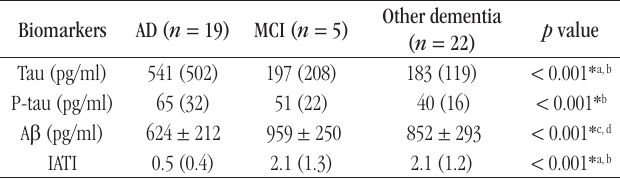
taBLE 1 − Comparison of Tau, P-tau and A β values and IATI in groups with AD, MCI and other dementia